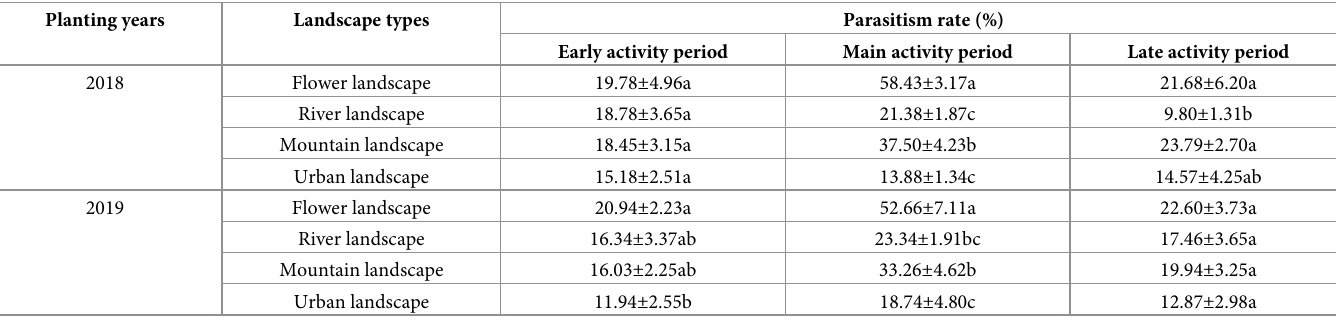
Eretmocerus except for those in the urban landscape. Qiu et al . and Li et al . also reported that Table 5. Parasitism rates in different types of landscapes in Kunming, south